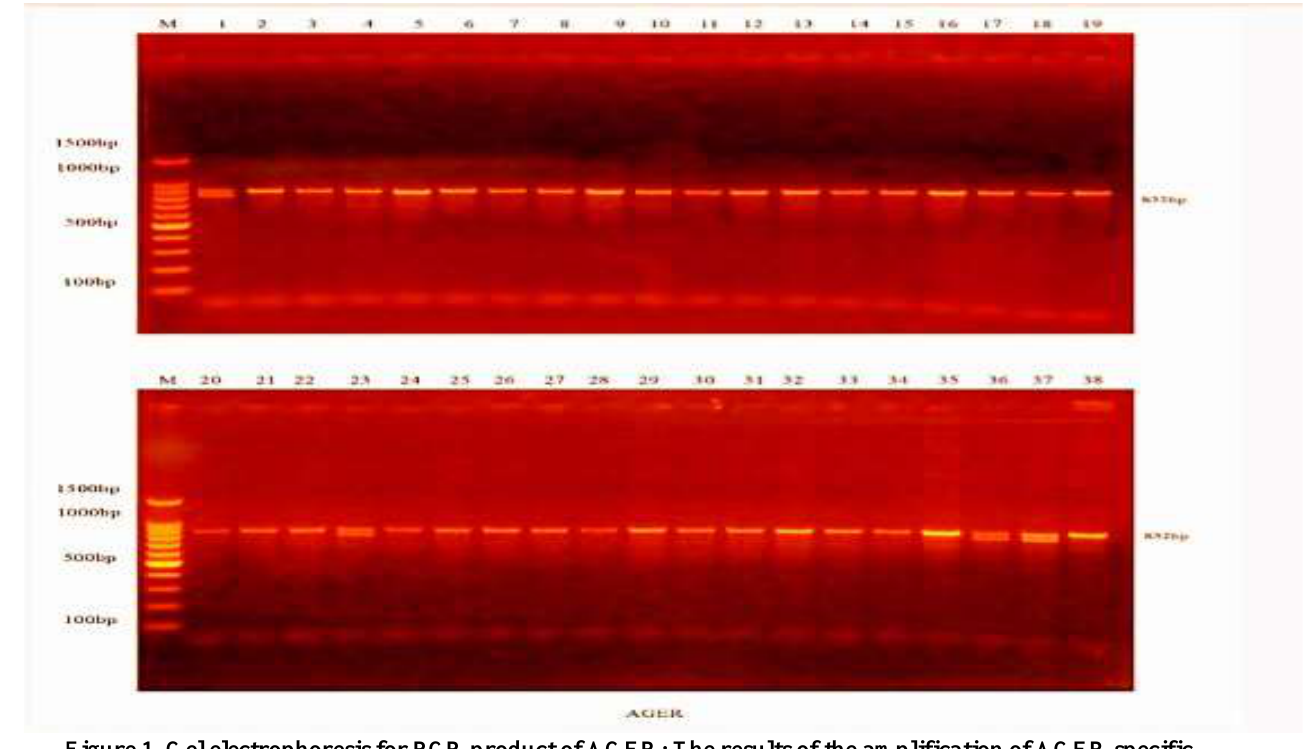
Figure 1. Gel electrophoresis for PCR product of AGER: The results of the amplification of AGER specific gene region of Human samples were fractionated on 1.5% agarose gel electrophoresis stained with Eth.Br. M: 100bp ladder marker. Lanes 1-38 resemble 832bp PCR products.